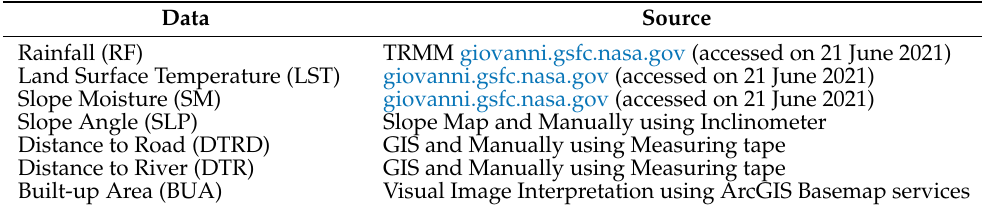
Figure 4. Field photographs while collecting data for model parameterization. Table 1. Data used in this study along with their